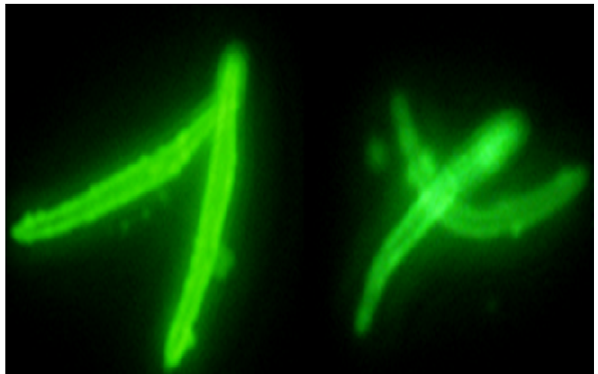
Figure 1. Immunofluorescence Assay. Air dried Pv spz were immunostained with monoclonal antibody against PvCSP (NVS3) at 0.98 ng/mL as described in Materials and Methods. The end point titer is 1:1,024,000.